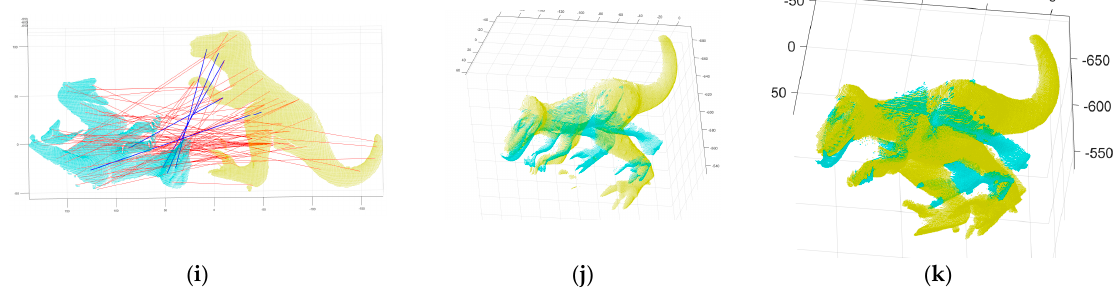
Figure 3. 3D registration results for the random sample consensus (RANSAC)-based method and some failure cases: ( a ) histogram of the number of inliers classified by RANSAC for two input data of Figure 2a,b, ( b ) the refined registration obtained by applying the ICP to range images aligned with the 6 inliers detected by the RANSAC-based method, ( c , f , i ) the correct and incorrect matches detected by the RANSAC-based method, where blue and red lines denote a correct one and a mismatch, respectively, ( d , g , j ) range images aligned with the 3, 4, and 5 inliers detected in ( c , f , i ), respectively, ( e , h , k ) the refined registration result of ( d , g , j ) by ICP, respectively.